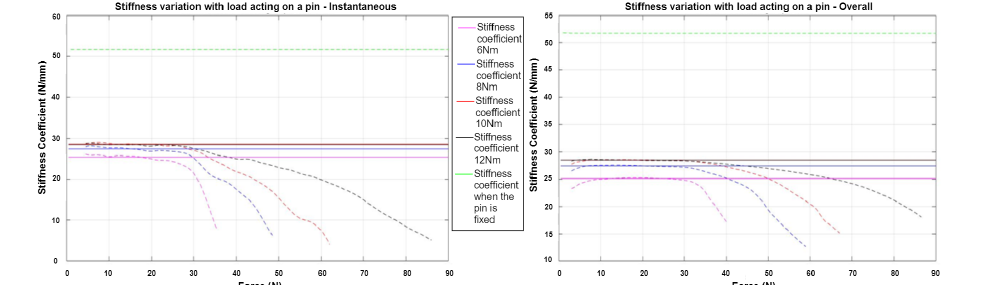
Figure 17. Variation of stiffness coefficient with load for different tightening loads (6 Nm—Magenta, 8 Nm—Blue, 10 Nm—Red, 12 Nm—Black) and for test when pin is fixed to testing block. Dashed lines—Actual values, Solid lines—Approximated